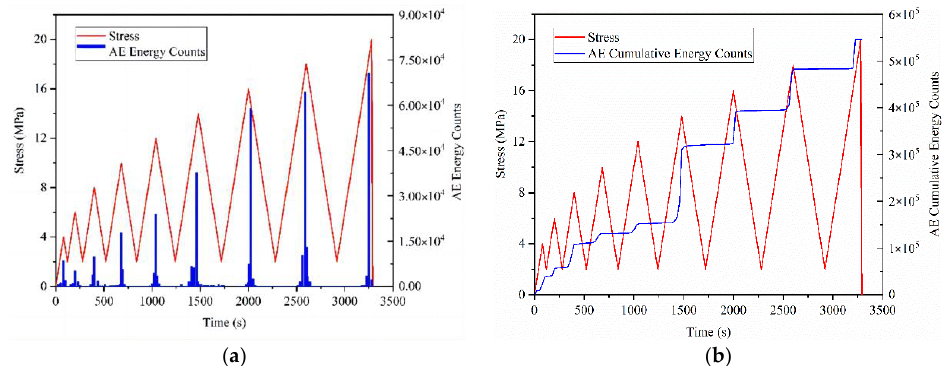
Figure 5. The AE energy characteristics of AC1 coal specimen; ( a ) Stress–Time–AE energy counting curve; ( b ) Stress–Time–AE cumulative energy counting curve.